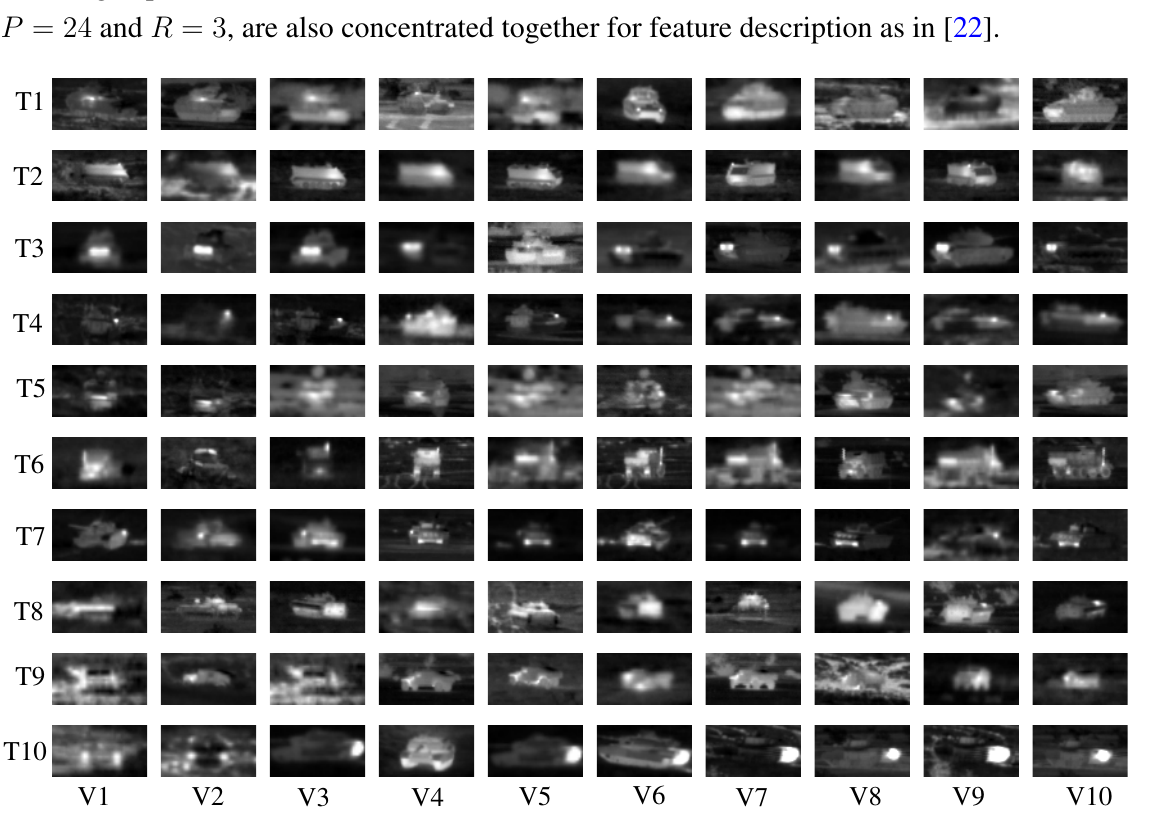
Figure 7. Some infrared chips of the 10 targets (row-wise) in 10 views (column-wise) in the forward-looking infrared (FLIR)